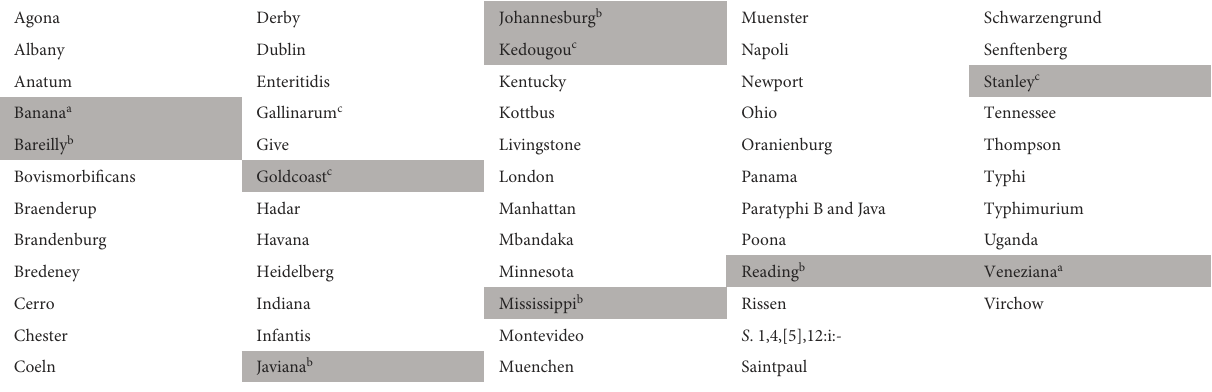
TABLE 1 List of the 58 Salmonella serovars identified as being the most frequently isolated in humans and the agri-food sector over a period of 10 years (from 2006 to 2016) in the United States, Europe and France.